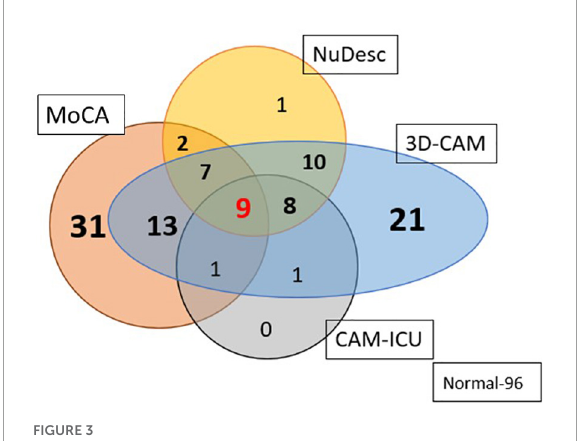
FIGURE3 Venn diagram representing the number of patients diagnosed as having PACU delirium based on the three different assessment methods; and their relationship to preoperative cognitive impairment, as detected using the MoCA. 3D-CAM was assumed to be the standard of delirium diagnosis. Out of a total of 70 patients graded as delirium present by the 3D-CAM, the CAM-ICU picked up only 27% and the NuDESC picked out 52.8% (96 individuals had no impairment pre-op and post